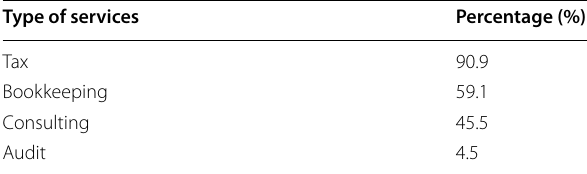
Table 1 Types of services provided to cannabis‑related businesses (CRB) reported by survey